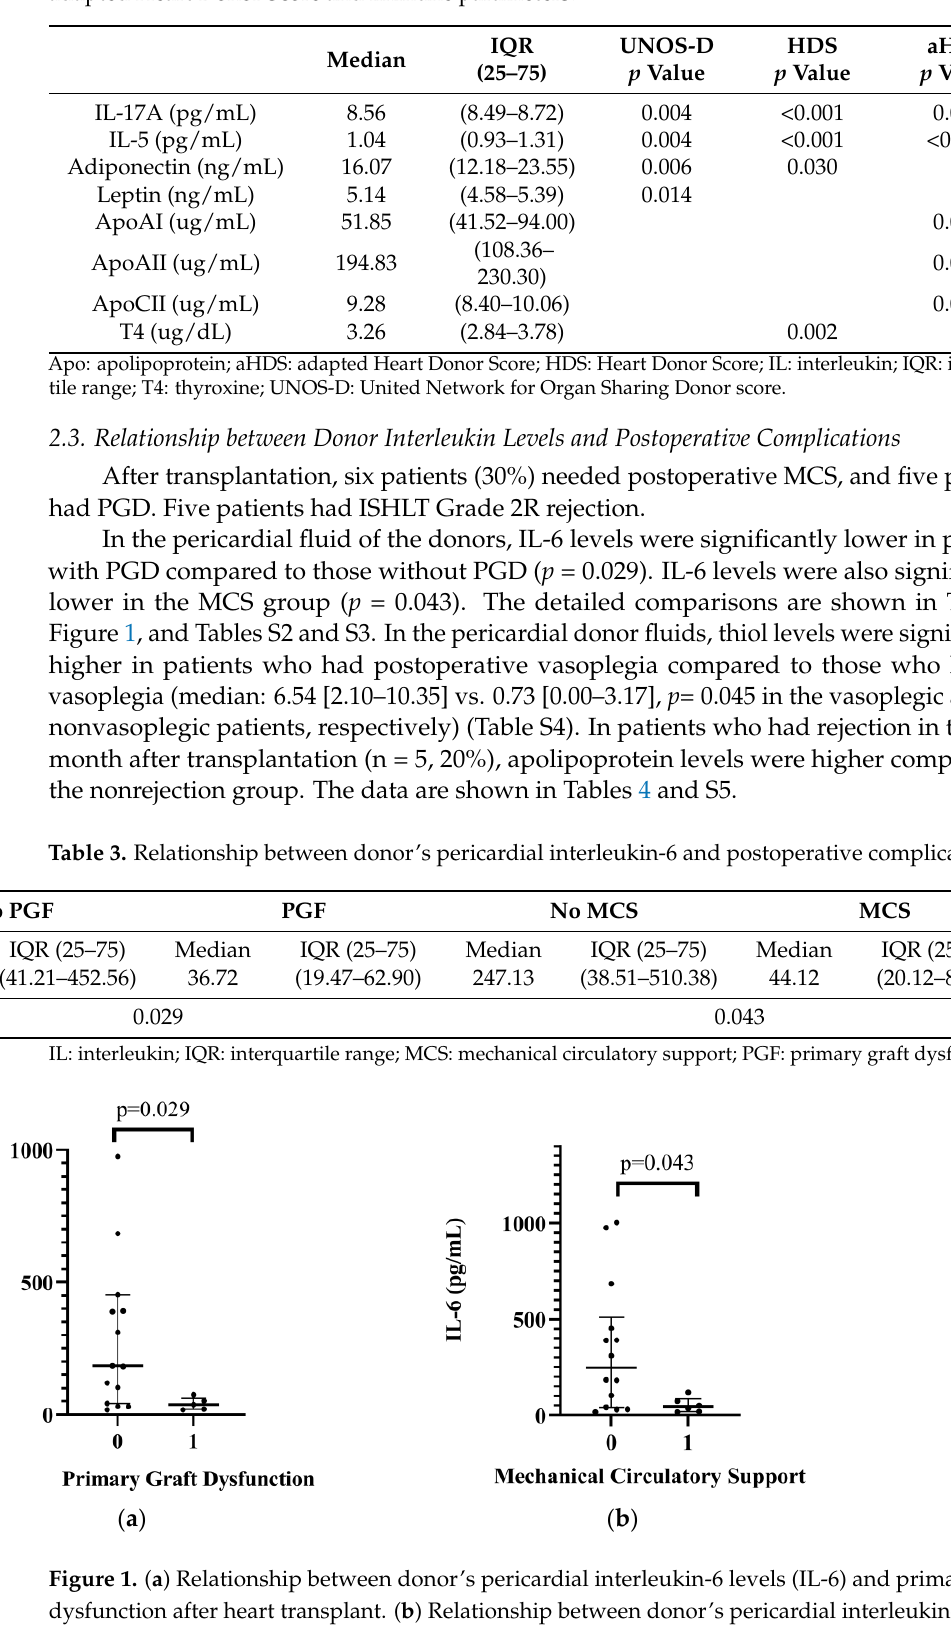
Table 2. Relationship between UNOS Donor Score as continuous variable, Heart Donor Score, adapted Heart Donor Score and immune parameters.